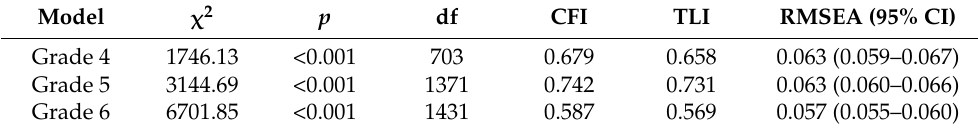
Table 12. Results of the confirmatory factor analysis of the visual communication test by grade. Model